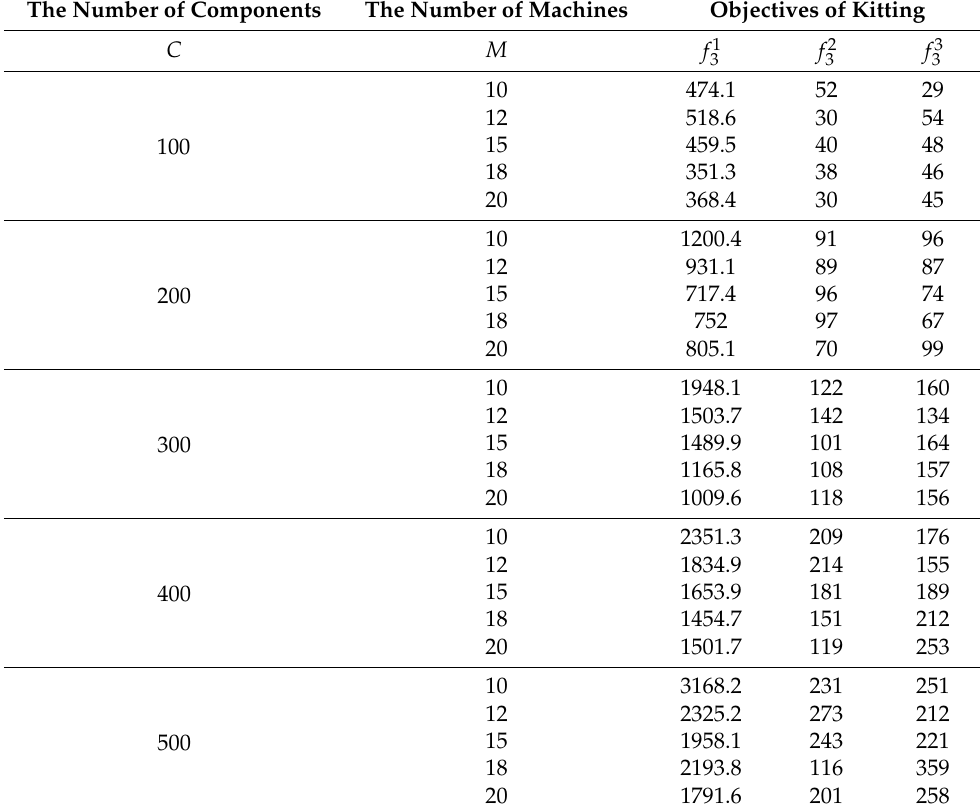
Table 3. Computational results for large-size